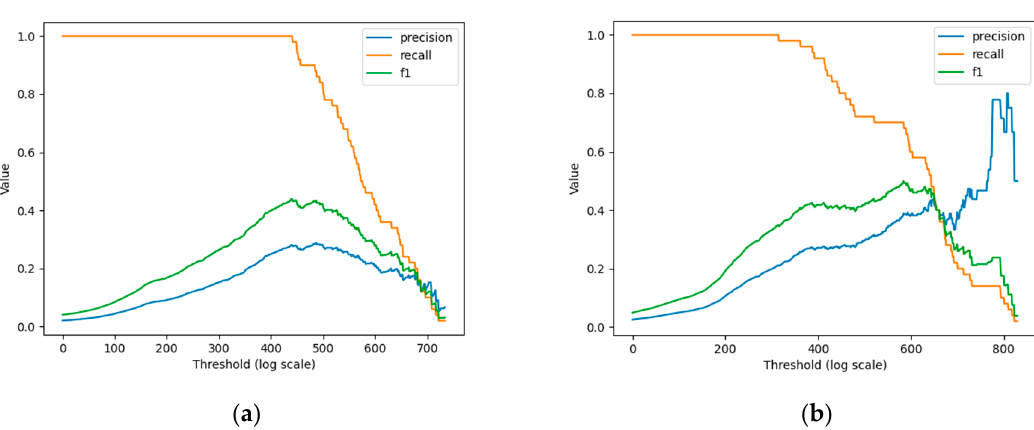
Figure 11. AC-LSTM abnormal score effect.